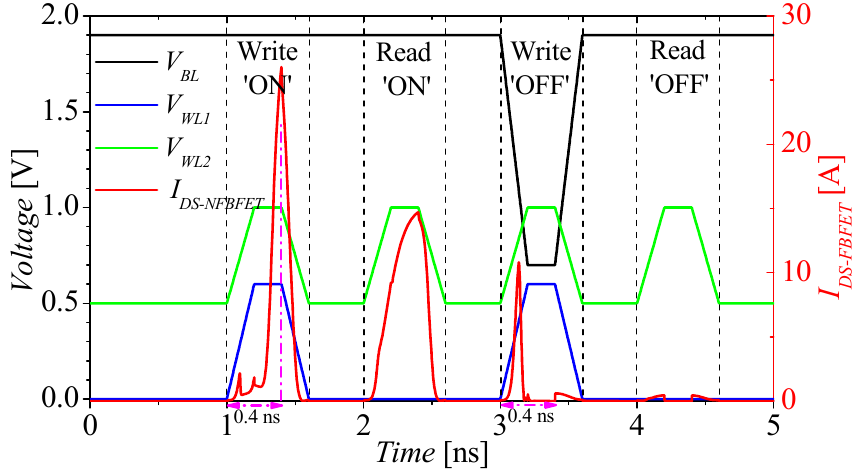
Figure 5. Timing diagram of the M3D − FBFET − SRAM cell operation.